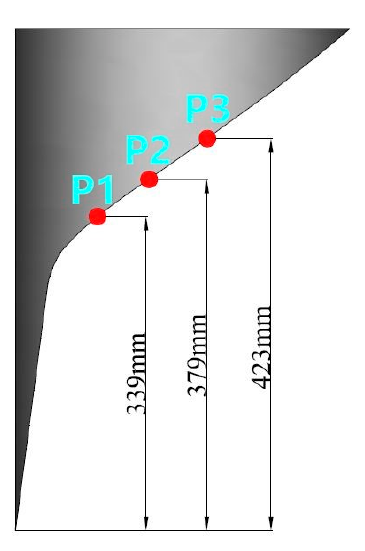
Figure 3. Pressure gauges of the model.